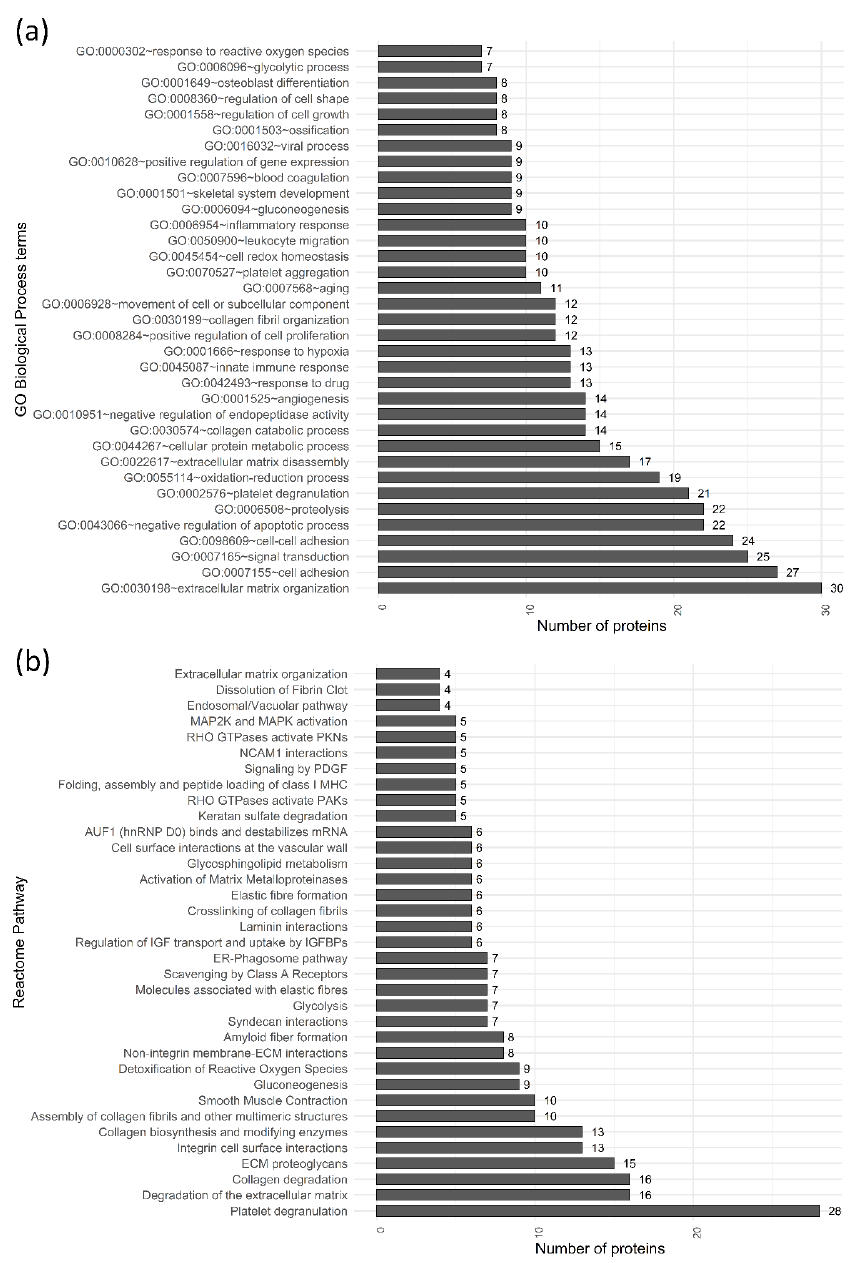
Figure 2. Bar charts representing functional annotation of proteins identified in the FetMSCs secretome by ( a ) gene ontology biological process and ( b ) reactome databases [21]. Top-35 categories are represented.